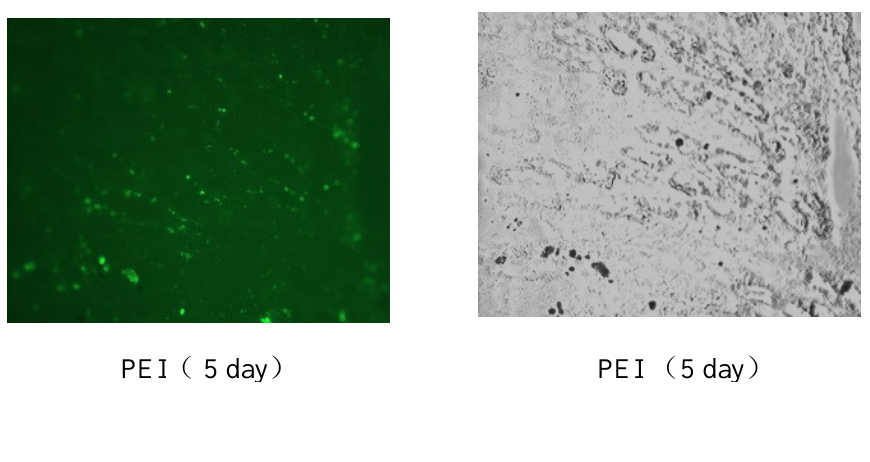
Figure 7. The results of gene delivery for mouse muscle with EGDMA-PEI 2000-2h and 25 k-Da branched PEI ( · 20 original magnification). (A) The results of gene delivery for mouse muscle with EGDMA-PEI 2000-2h, Control: PBS only, no plasmid, no polymer; Cross-linked PEI Control: Polymer in PBS, no plasmid. DNA Control: plasmid only. (B) The results of gene delivery for mouse muscle with 25 k-Da branched PEI , Control: PBS only, no plasmid, no PEI; PEI Control: PEI in PBS, no